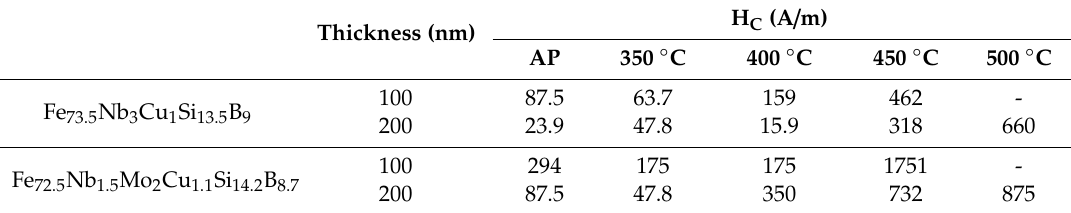
Table 2. Coercivity of the Fe 73.5 Nb 3 Cu 1 Si 13.5 B 9 and Fe 72.5 Nb 1.5 Mo 2 Cu 1.1 Si 14.2 B 8.7 thin films in the as-prepared state and after the heat